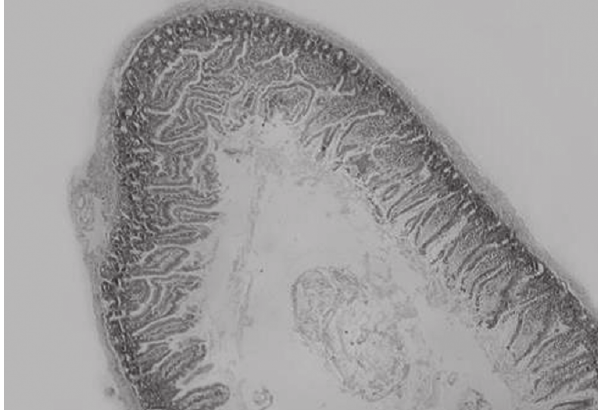
Figure 5 - Histological appearance of the SNP+L-NAME group. An increase in the amount of subepithelial spaces and epithelial separations (H&E